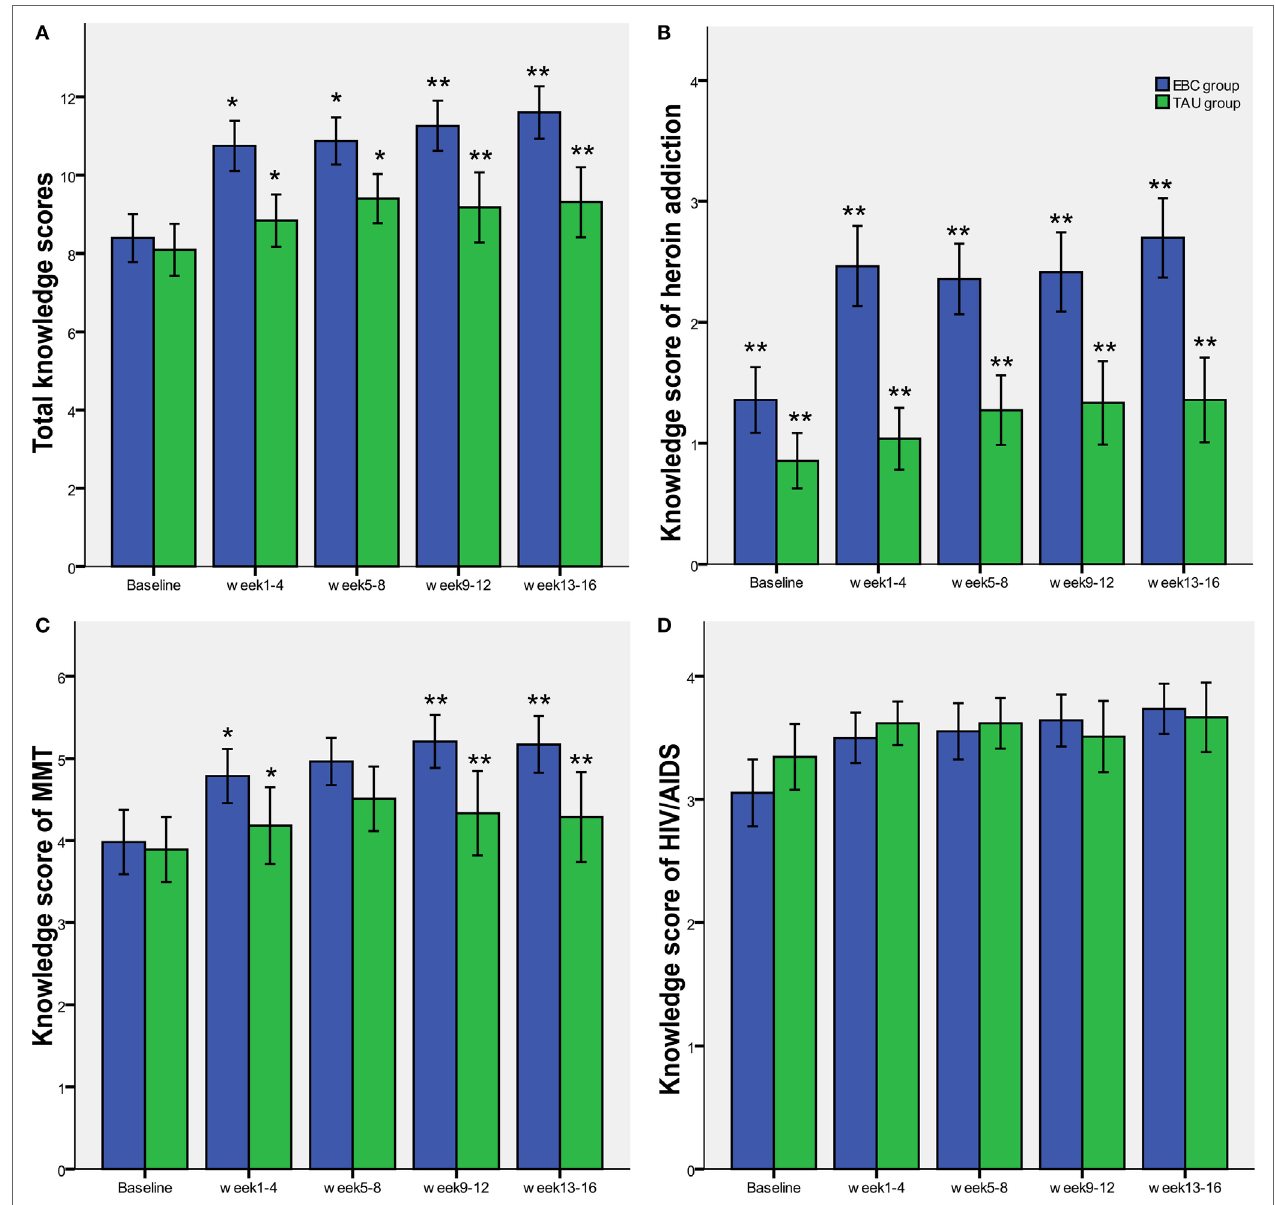
FigUrE 3 | Knowledge scores of educational and behavioral counseling (EBC) and treatment as usual (TAU) group. (a–C) presented significant differences between the EBC and TAU group on the total knowledge scores and knowledge subgroup scores related to heroin addiction and methadone maintenance treatment, and (D) showed that there is no significant difference between the EBC and TAU group on the knowledge subgroup scores related to HIV/AIDS (* P < 0.05, ** P <